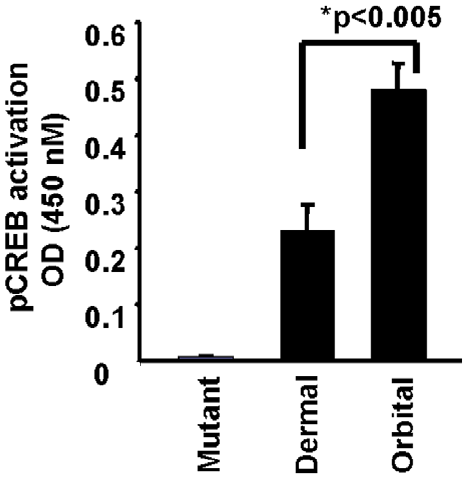
Figure 9. PGE 2 enhances DNA binding of pCREB preferentially in orbital fibroblasts. Eighty percent confluent cultures were serum starved for 20 h and then treated with PGE 2 (1 m M) for 16 h. Nuclear extracts (5 m g) were subjected to the TransAM ELISA for detecting pCREB/DNA complexes as determined at 450 nm. Data are expressed as the mean 6 SD of triplicate independent determinations from a single orbital and dermal fibroblast strain. They were representative of results from 3 strains of each which demonstrated 2.1 fold greater pCREB binding in orbital versus dermal strains.